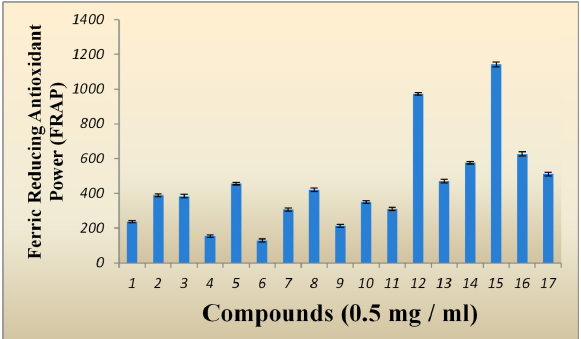
Each value is expressed as mean ± SD (n = 3). Antioxidant activity (µmol Trolox /100 g). Figure: 3: Ferric reducing antioxidant power (FRAP) of compounds